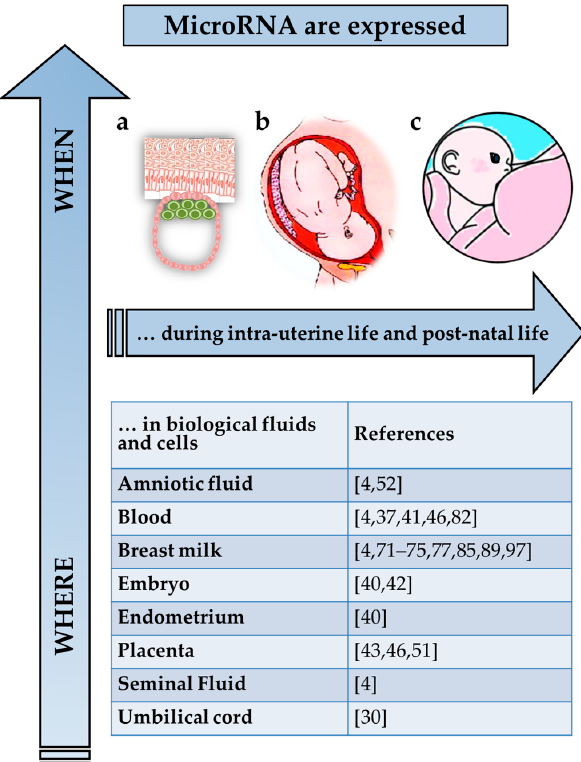
Figure 1. MicroRNA in the maternal-offspring biologic interchange. MicroRNA are expressed in cells and body fluids continuously during intra-uterine ( a , b ) and post-natal life. After birth, the dynamic, bidirectional interchange of bioactive components, including specific miRNA, continues and can occur through breastfeeding. ( c ) miRNAs expressed constitutively and those which are expressed in a tissue-specific manner in response to environmental stimuli remains to be determined.